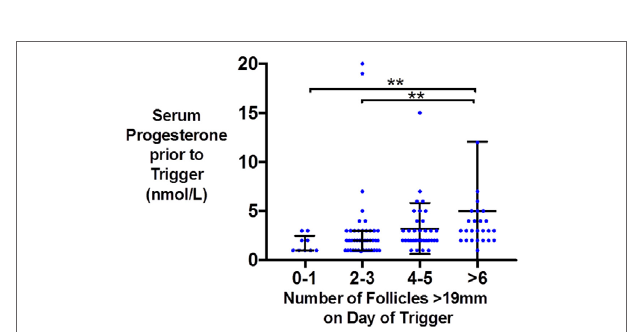
FigUre 2 | Scattergram (median and interquartile range) of serum progesterone (nmol/l) just prior to trigger administration by the number of follicles > 19 mm on the day of kisspeptin trigger